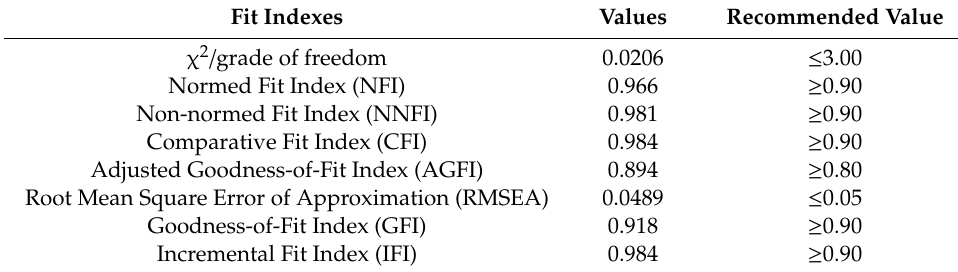
Table 4. Goodness of fit